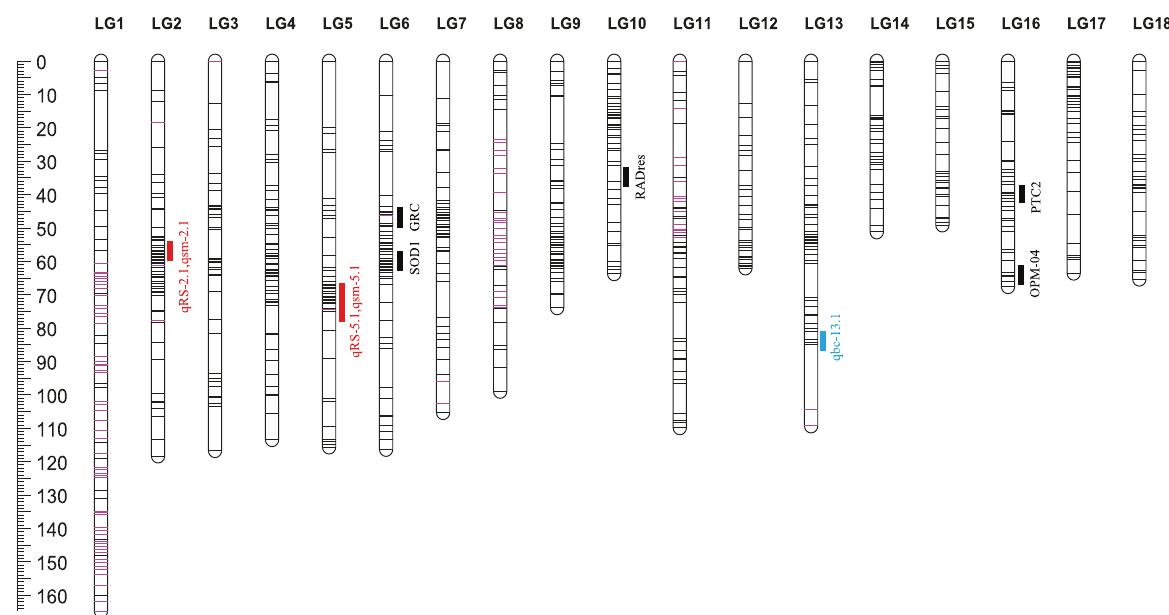
Fig. 7 Distribution of QTLs and SNP markers on the 18 LGs. The markers derived from segregating normal and segregating distorted regions are presented as black and pink, respectively. Red solid bars indicate the QTL regions of snail resistance to parasites, and the blue solid bar show the QTL region for pigmentation identi fi ed in this study. The black solid bars indicate the QTL regions reported previously. OPM-04 23 , GRC 24 , RADres and SOD 25 , PTC2 26 . The RAPD marker OPZ-11 is not indicated because it is a repetitive sequence which could not be unambiguously